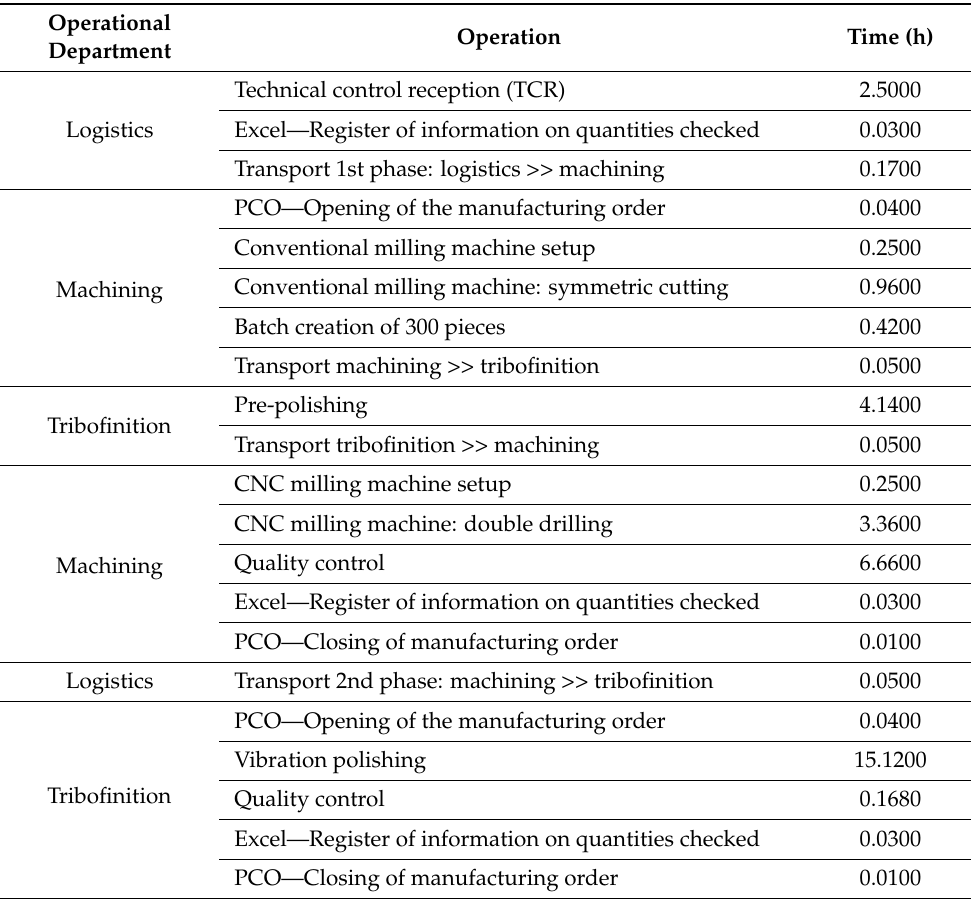
Table 7. Production flow operating times for the